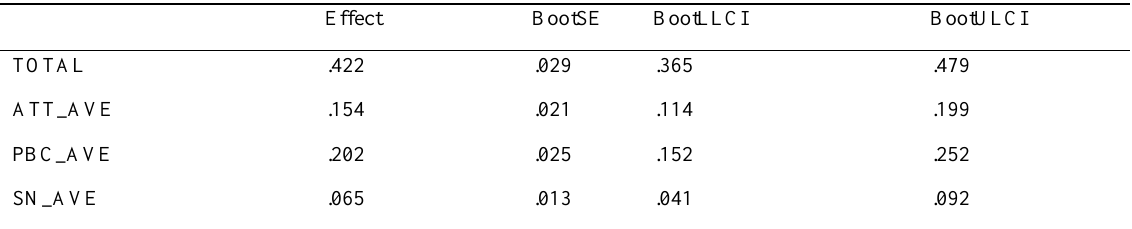
Table 9: Indirect effect(s) of Entrepreneurial Course on Entrepreneurial Intention Due to Mediation Effect